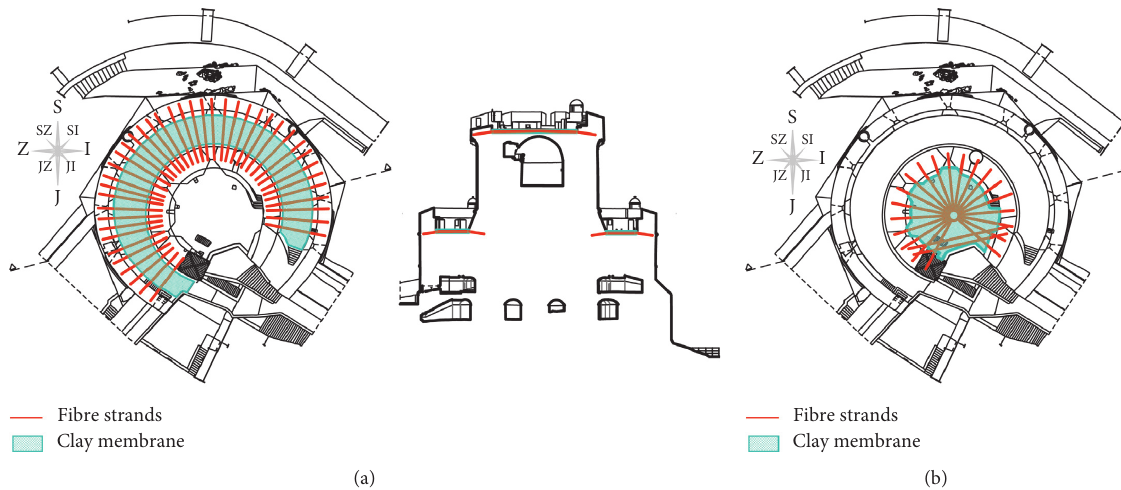
Figure 15: The position of the glass fibre strands for stiffening the tops of the fortress: (a) the terrace on top of the prewalls, (b) the terrace on top of the new